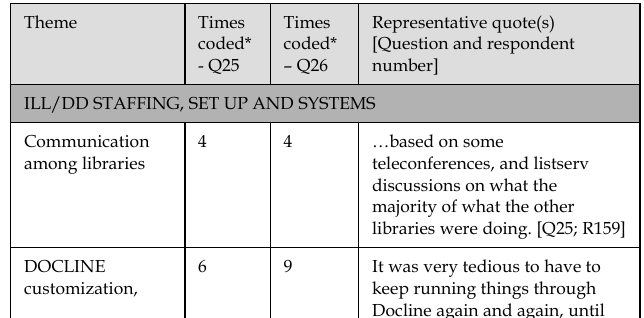
Table 1 Qualitative analysis of open-ended questions (Q25, N=258 and Q26, N=118) represented by eleven themes